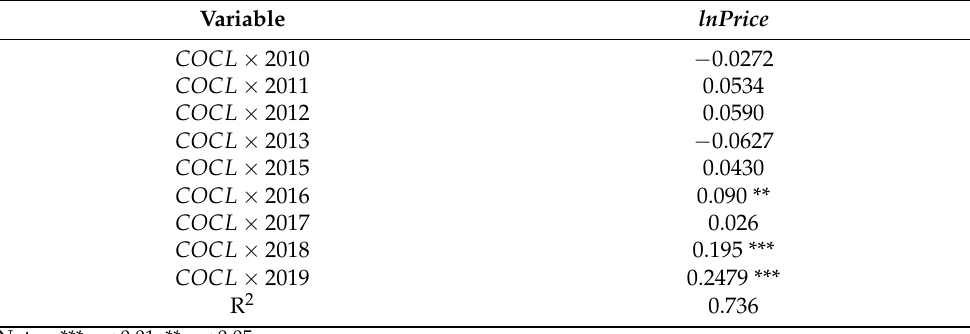
Table 8. Assumption of parallel trends of SIL transaction price.